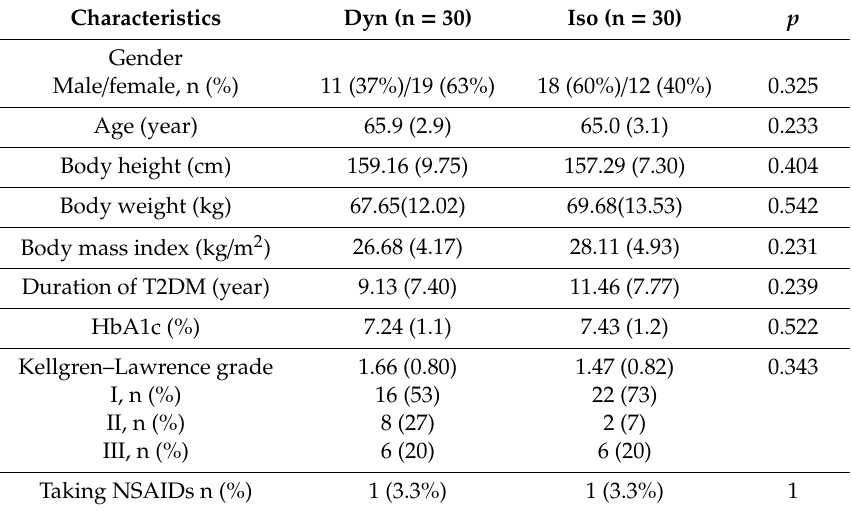
Table 1. Baseline characteristics of participants.